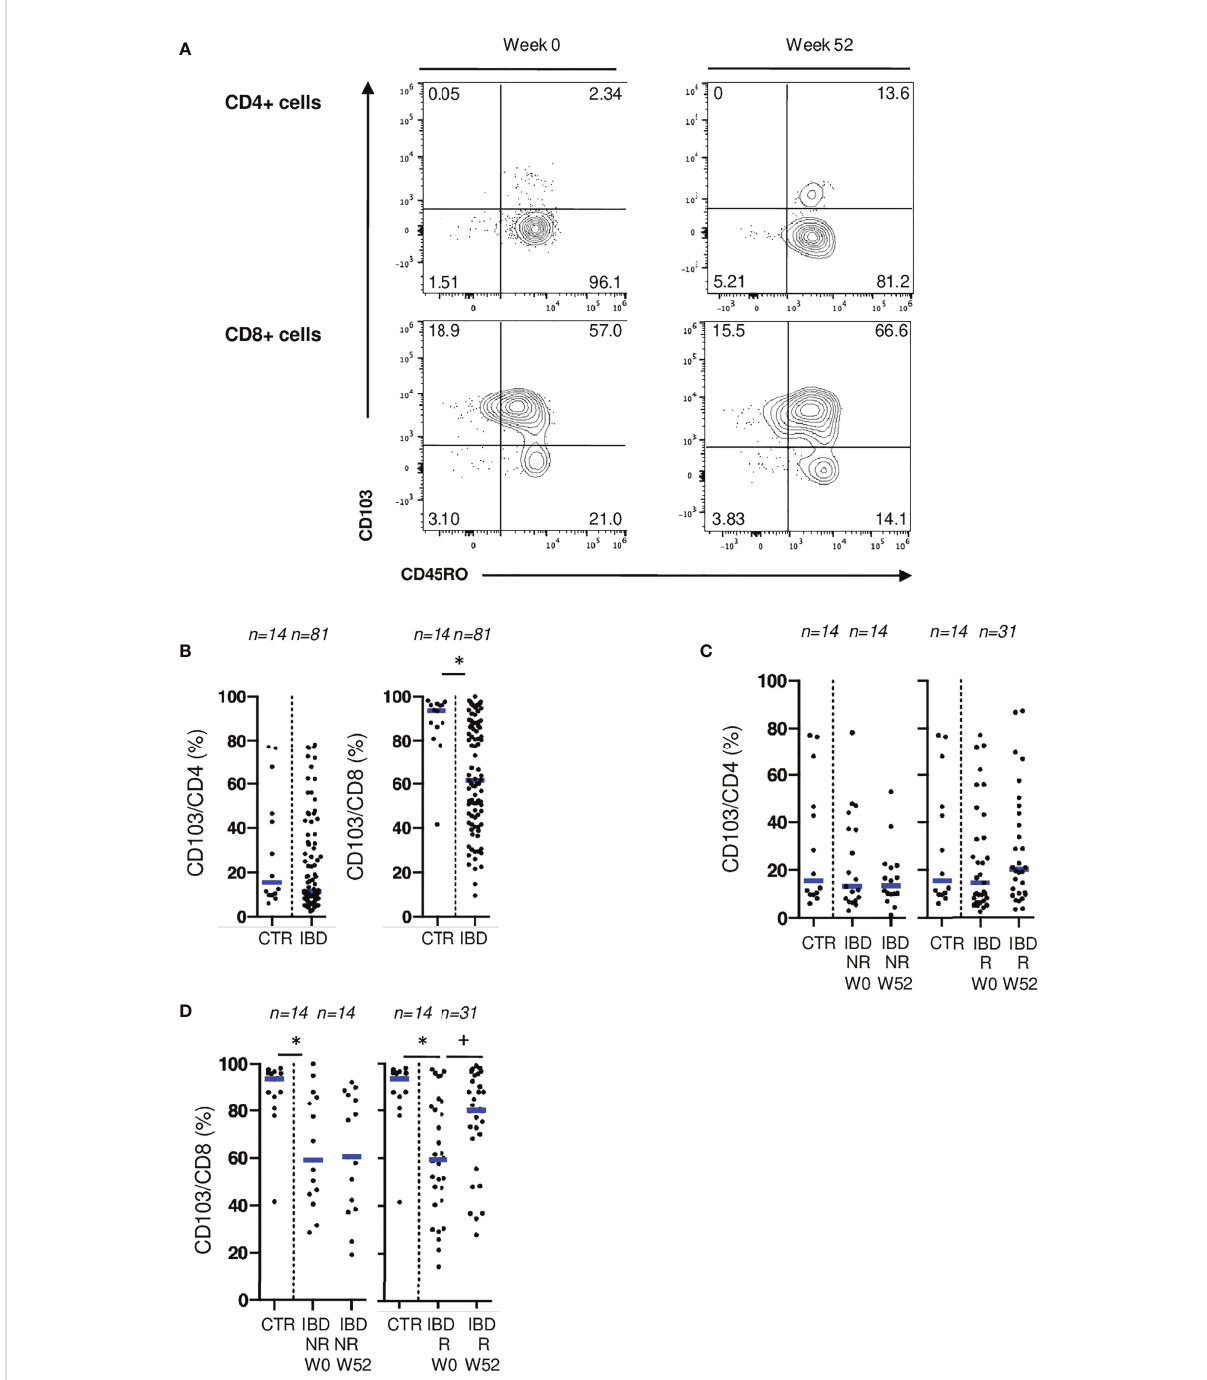
FIGURE 5 CD103 expression on mucosal T cells is associated with IBD disease activity. (A) Gating strategy for CD103 and CD45RO stainings in fl ow cytometry. (B) Comparison of mucosal rates of CD4 and CD8 T cells expressing CD103 between controls and patients from the ELYP cohort at week 0. (C) Evolution of mucosal rate of CD8 T cells expressing CD103 rates in IBD patients from the ELYP cohort without or with endoscopic response to biotherapy. (D) Evolution of mucosal rate of CD4 T cells expressing CD103 rates in IBD patients from the ELYP cohort without or with endoscopic response to biotherapy. CTR: ileal mucosal samples) CD= Crohn ’ s Disease, CTR= Control, IBD= In fl ammatory Bowel Disease, NR= Non Responders, R= Responders. *p < 0.05 Mann Whitney Test; +: p < 0.05 Wilcoxon Paired